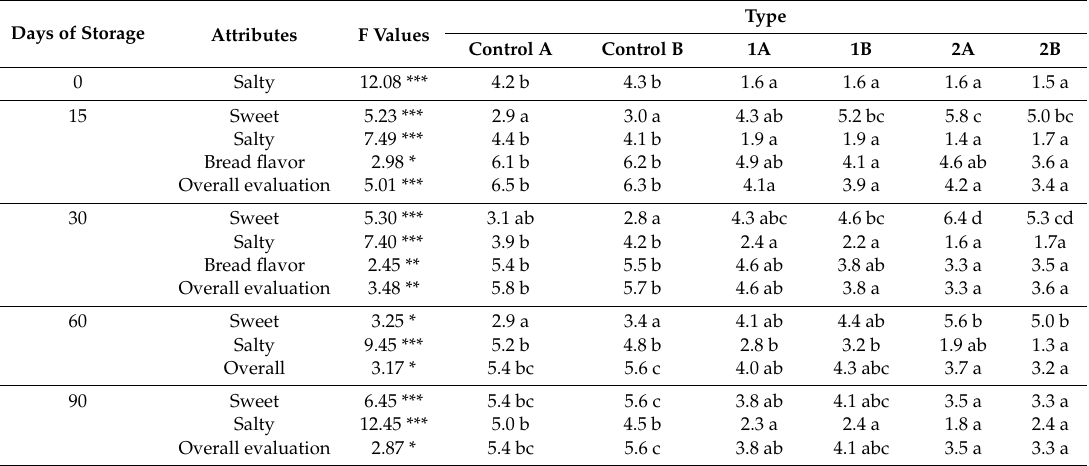
Table 9. Influence of type of bread (6) on the attributes and mean scores of the significant sensory attributes (comparison of formulations). Data expressed as